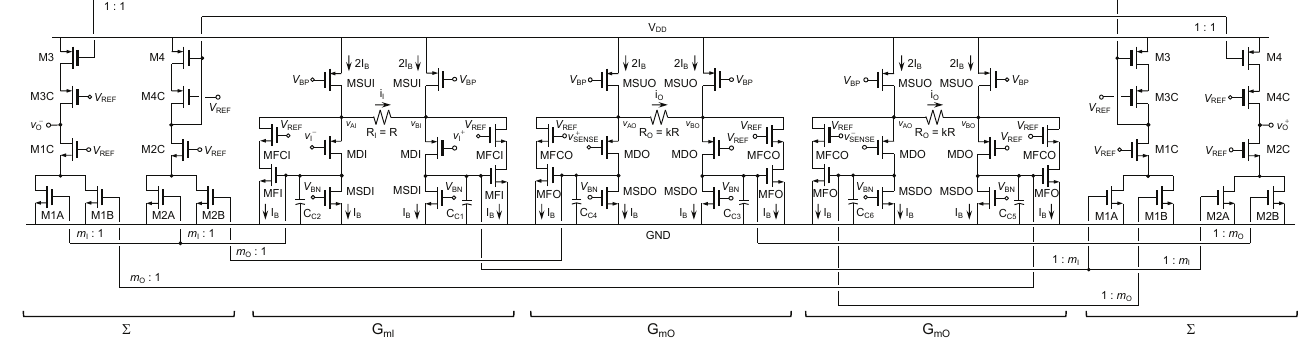
Figure 4. Circuit schematic of the proposed pseudo-differential ICF